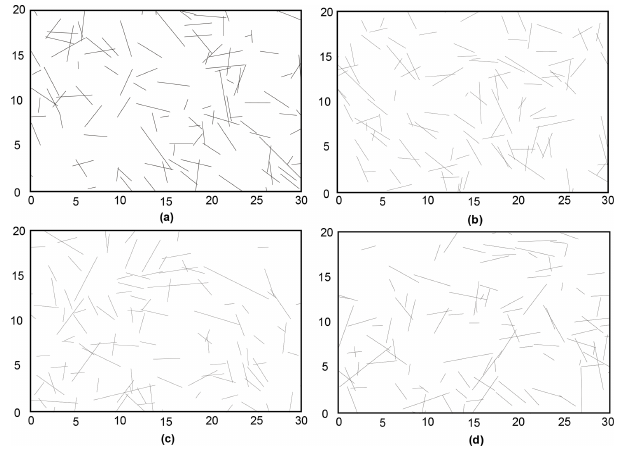
Figure 4. Variability in DFN simulation. (a)–(d) The DFN models in four simulations. The line segments in the rectangle frame repre- sent the fractures, and the left boundary of the frame represents the exposed surface.